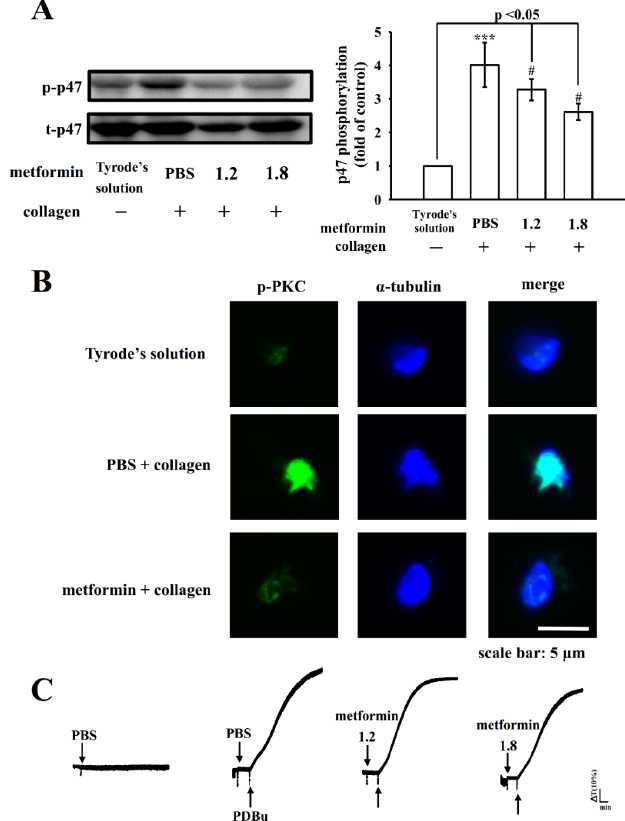
Figure 4. Effectiveness of metformin in protein kinase C activation in platelets. Washed platelets were preincubated with PBS or metformin (1.2 and 1.8 mM) and treated with collagen (1 μ g/mL) for immunoblotting of ( A ) protein kinase C (PKC) activation (pleckstrin; p-p47) or ( B ) detecting confo- cal images of PKC activation (green fluorescence) and α -tubulin (blue fluorescence) using goat anti- rabbit CF TM 488A and anti-mouse CF TM 405M Dyes, respectively. ( C ) For other study, washed plate- lets were preincubated with PBS or metformin (1.2 and 1.8 mM) and treated with phorbol 12,13- dibutyrate (PDBu, 150 nM) to stimulate platelet aggregation. Data are presented as mean ± standard error of the mean ( n = 4). *** p < 0.001 vs. Tyrode’s solution group; # p < 0.05 vs. PBS + collagen group. The confocal images and profiles in ( B ) are the representative of four independent experiments. Bar: 5 μ m. 3.4. Regulatory Activity of PI3K–Akt–GSK3 β and MAPK Activation by Metformin A study indicated that high shear stress induces thrombus formation via PI3K/Akt/GSK3 β [20]. PI3K stimulation is greatly involved in platelet activation and plays a critical role in regulating Akt activation [20]. Akt (protein kinase B (Ser/Thr kinase)) is